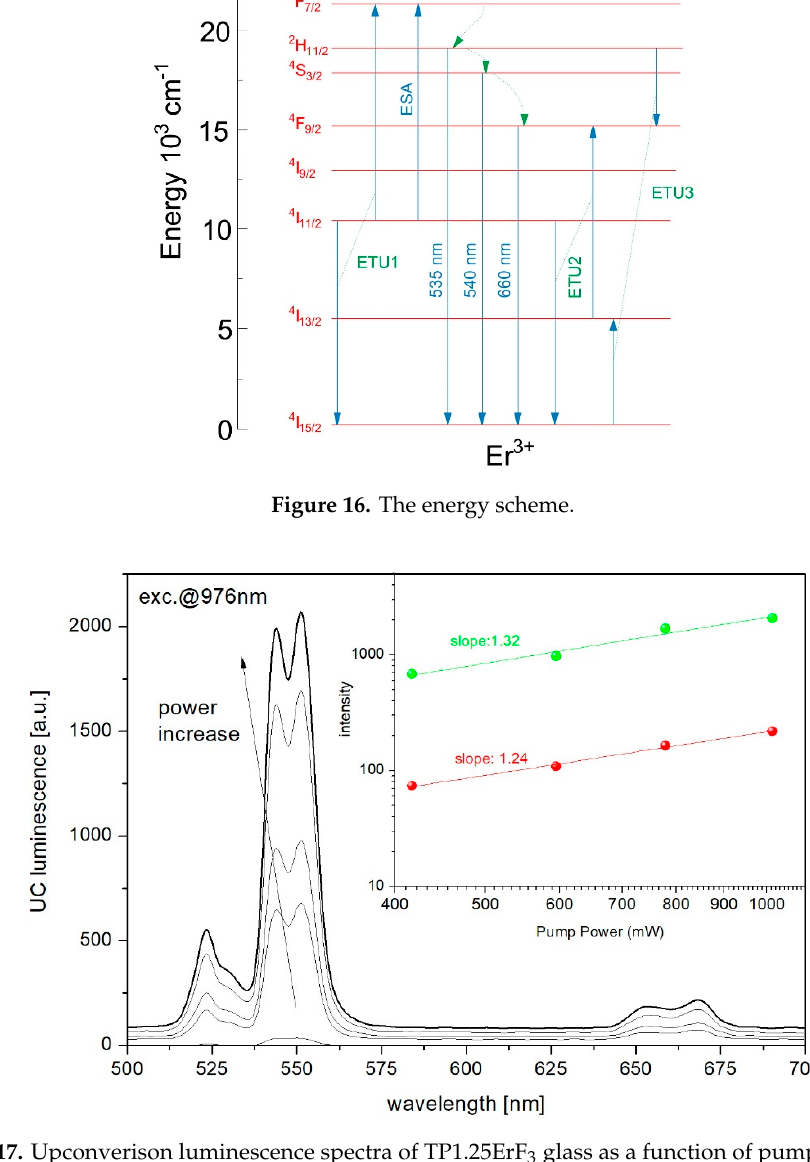
Figure 17. Upconverison luminescence spectra of TP1.25ErF 3 glass as a function of pumping power. (inset) The log-log dependency of upconversion emission intensity for green and red radiative transitions.